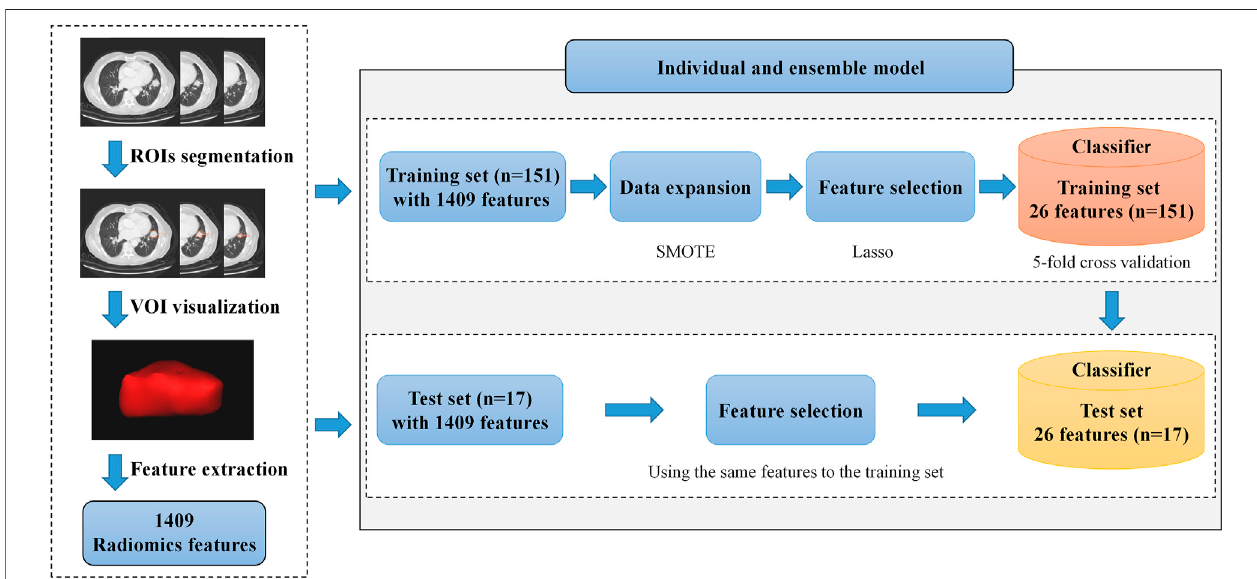
FIGURE1 | Frameworkof ourproposed radiomics model. Itincludes volume ofinterest (VOI) segmentation,radiomics featureextraction, and model construction. In the model construction process, we make data expansion with the SMOTE on the training set and feature selection on the training and the test sets. The most appropriate hyperparameter of the model is selected by the average accuracy on the validation set in the training process, and the best model is sent to the testing process.